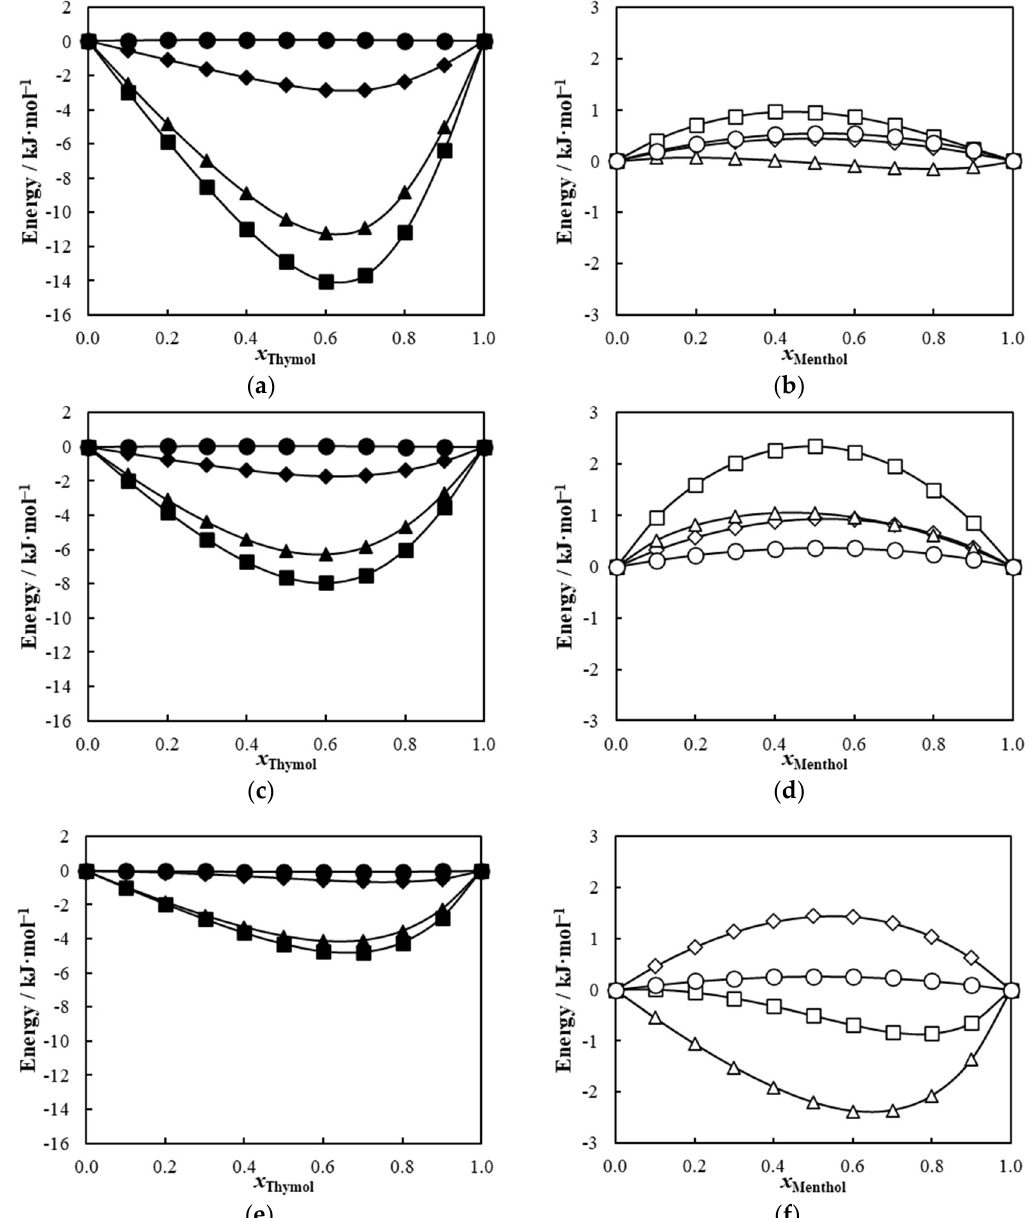
Figure 3. Excess enthalpies predicted by COSMO-RS, at 298.2 K, for the systems thymol/flavone ( a ), menthol/flavone ( b ), thymol/flavanone ( c ), menthol/flavanone ( d ), thymol/hesperetin ( e ), and menthol/hesperetin ( f ). The symbols represent total excess enthalpy (□), misfit contribution ( ◇ ), hydrogen bond contribution ( △ ), and van der Waals contribution ( ○ ).